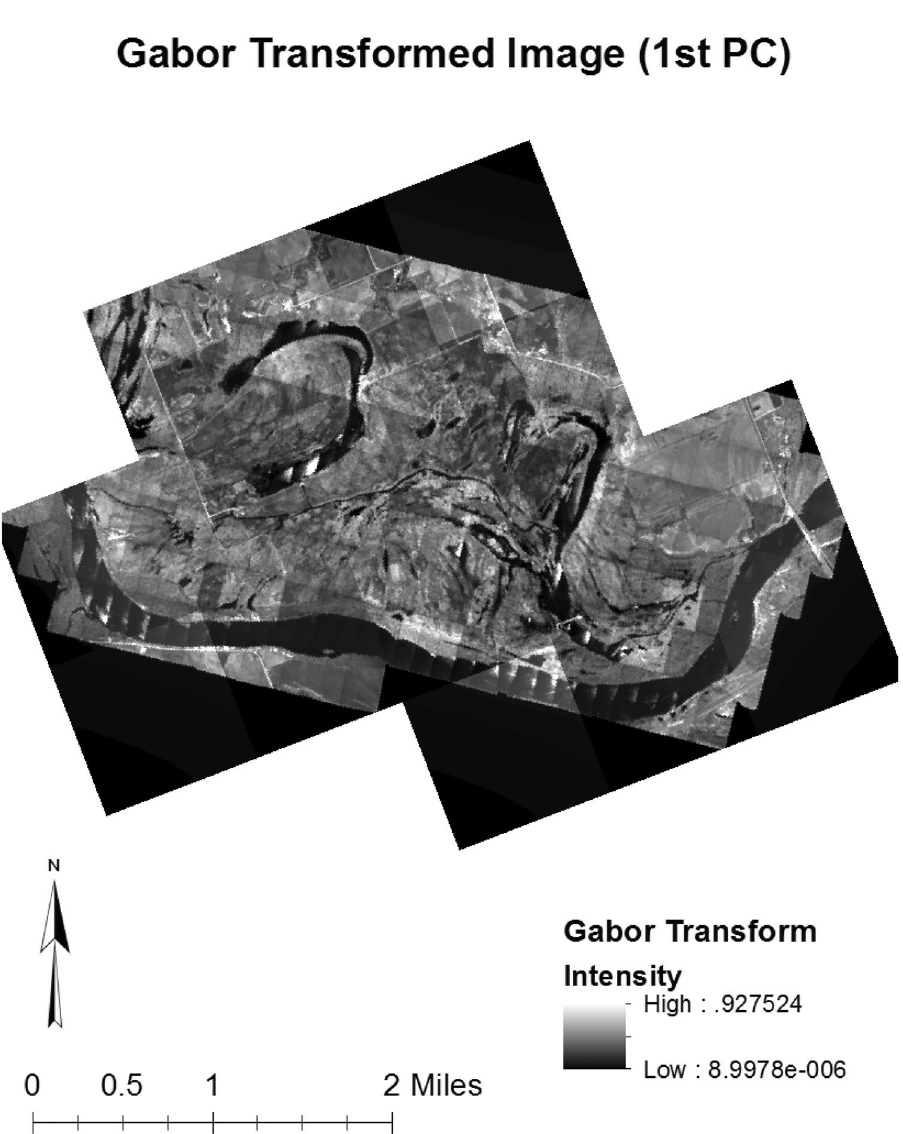
Figure 2. Gabor transformation. Gabor transformed image of study area derived from original image using the first principal component of all gabor outputs using the filter bank parameters. Software: ArcMap